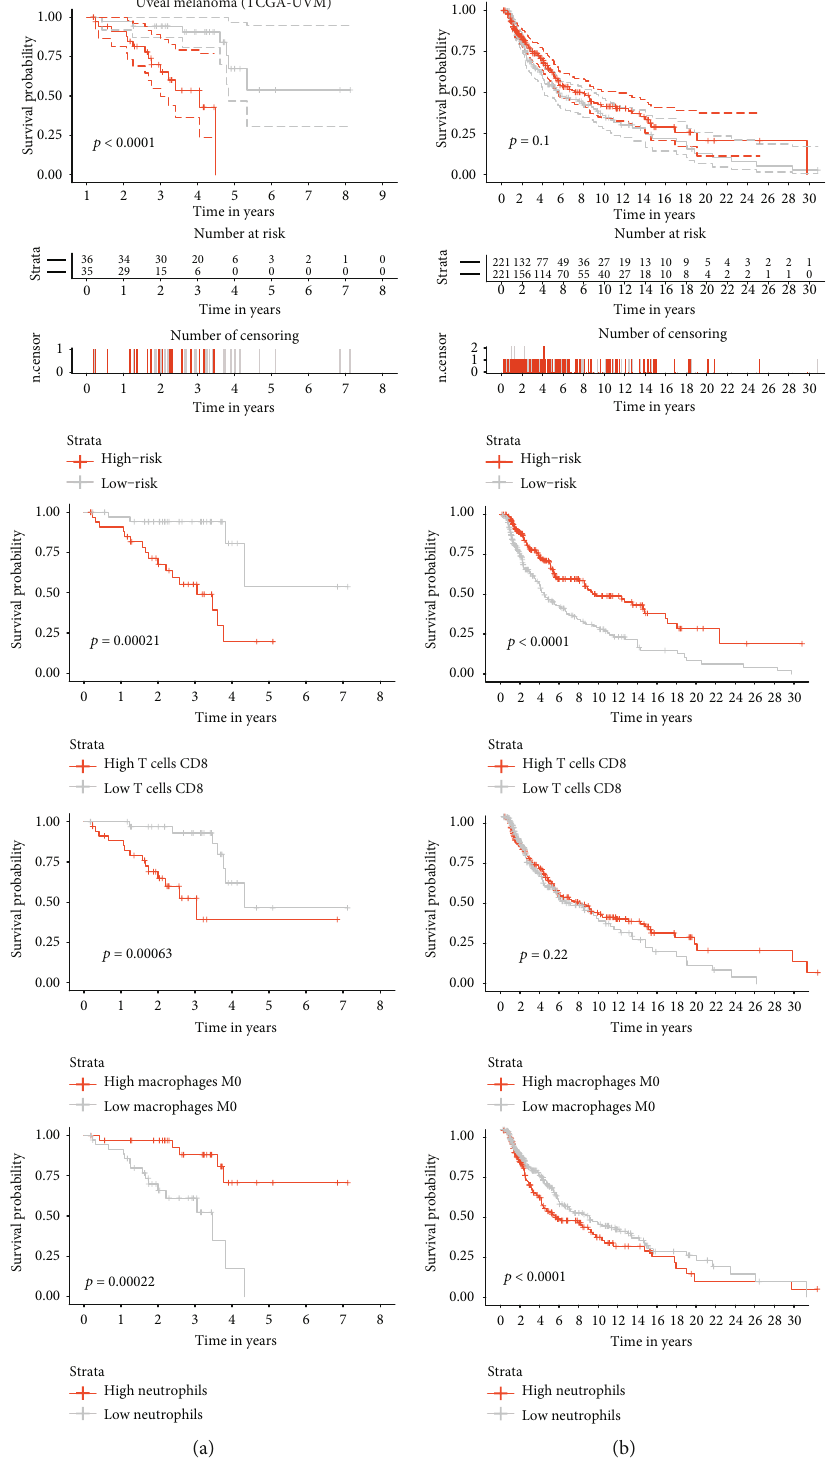
Figure 5: Comparison of Kaplan – Meier overall survival (OS) analysis based on the 3-cell type signature and each individual cell type separately between uveal (a) and cutaneous (b) melanoma. Di ff erences between the groups were detected by log-rank